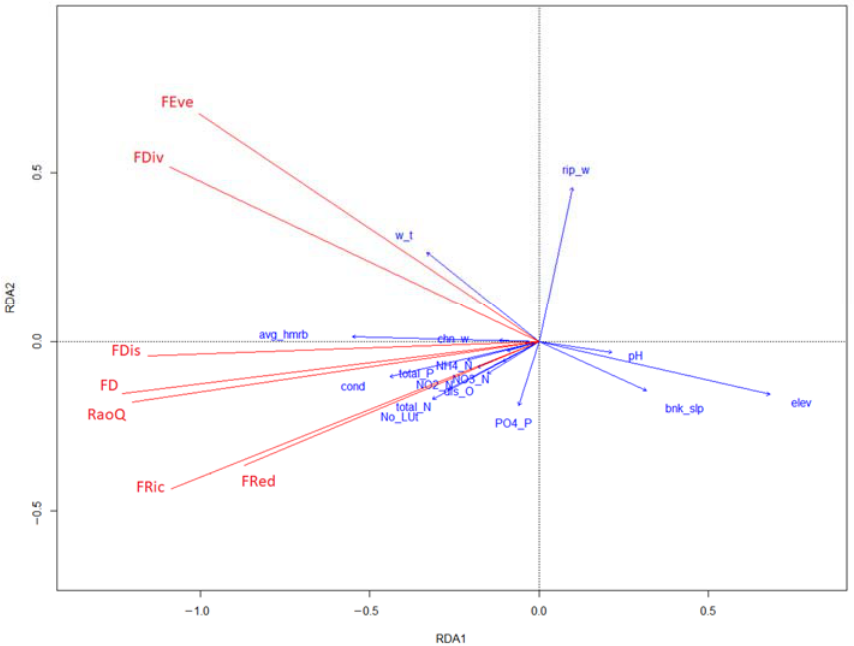
Figure 2. RDA plot of the environmental predictors and functional diversity indices as response variables, with scaling 2 applied. The abbreviated names of the environmental variables are given in Table 1, and those of functional diversity indices in Table 3. Conductivity and average degree of hemeroby had significant positive correlations and elevation a negative correlation with all functional diversity indices (Figure 3A). a negative correlation was found between bank slope and functional evenness and divergence. These two indices, as well as functional diversity, had a positive correlation with water temperature. The number of CORINE land cover classes had a positive correlation with functional richness, diversity, and redundancy. The coefficients of correlation between the other environmental variables and functional diversity indices were not statistically significant.